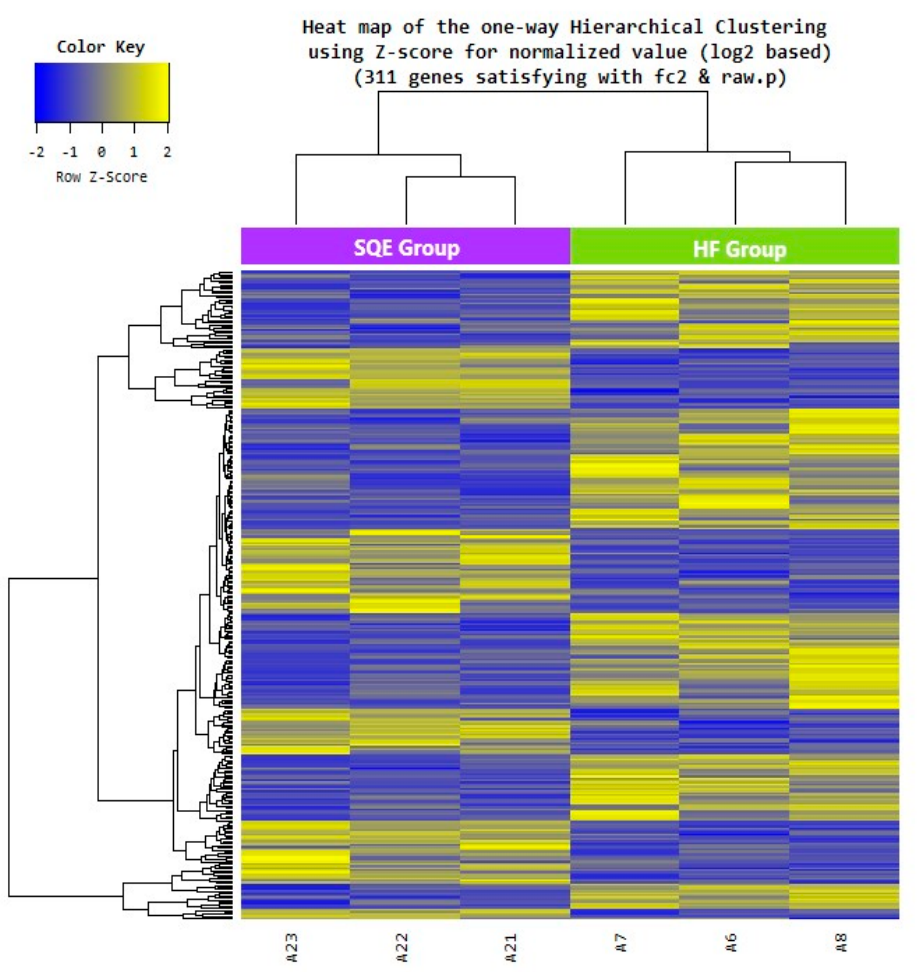
Figure 7. Heat map of the one-way hierarchical clustering using the Z-score for the normalized value from 311 differentially expressed genes (DEGs) between the SQE group and HF group. HF, high-fructose-diet-fed rats; SQE, the high-fructose-diet-fed rats supplemented with S. quelpaertensis leaf extract.